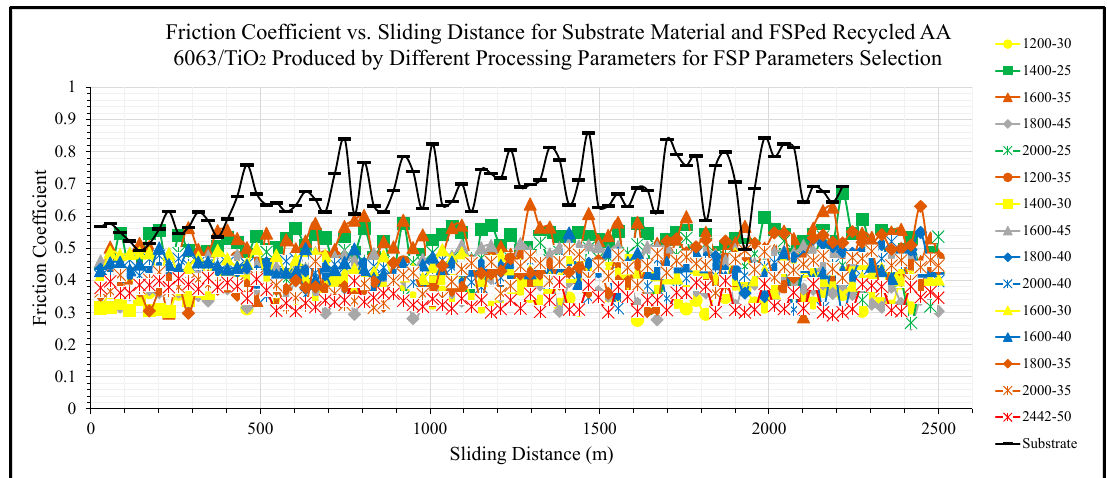
Sliding Distance (m) Figure 18. Sliding friction coefficient against sliding time of 2.5 km for substrate material and FSPed samples subjected to a nominal contact pressure of 0.24 MPa at a sliding speed of 2.88 m/s under starved lubrication conditions. Wear Rate of Substrate Material and FSPed Recycled AA 6063/TiO2 Produced by Different Processing Parameters